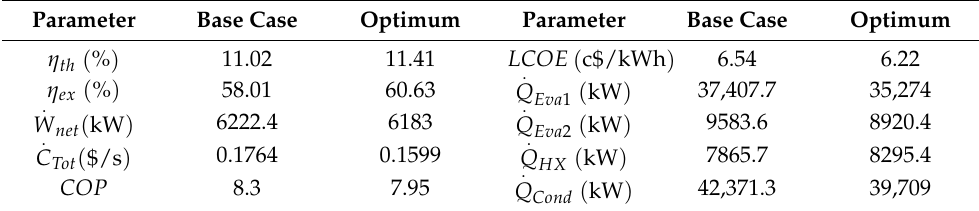
Table 13. The main calculated parameters of the cycle.